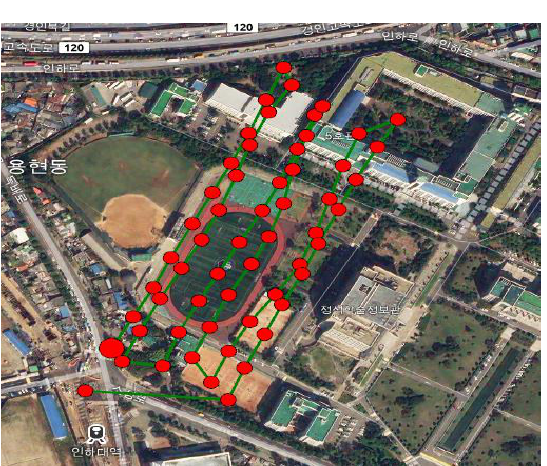
Figure 1. The first region (in urban)